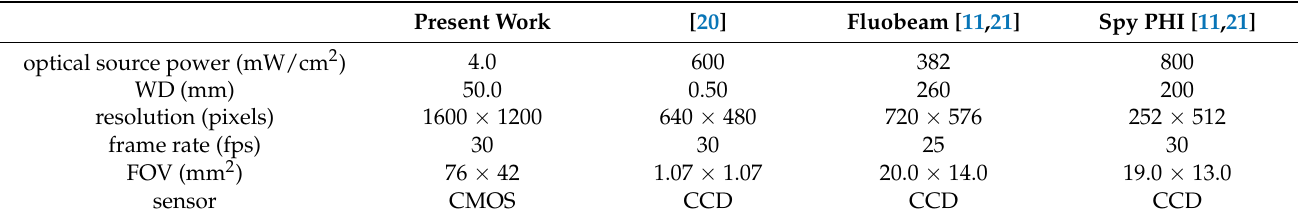
Table 1. Comparison of the performance of pen-type probe’s camera and others.